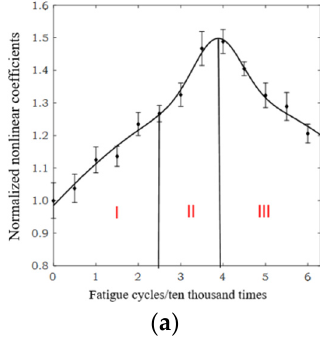
Table 3. Fatigue loading parameters of the SLM 316L stainless steel specimens.